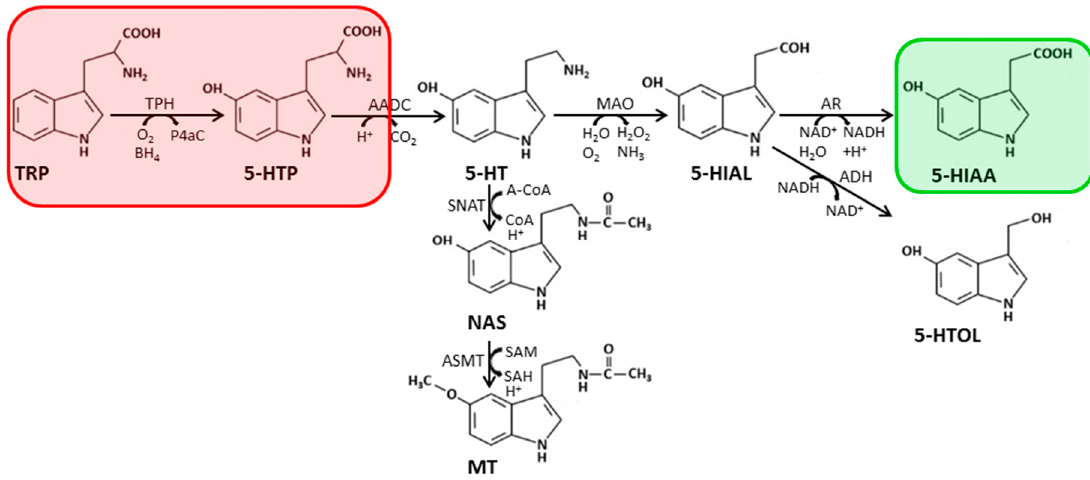
Figure 2. Biosynthesis and catabolism of tryptophan. A-CoA, acetyl coenzyme A; AADC, aromatic amino acid decarboxylase; ADH, alcohol dehydrogenase; AR, aldehyde reductase; ASMT, N -acetyl-serotonin- O -methyltransferase; CO 2 , carbon dioxide; CoA, coenzyme A; 5-HIAA, 5-hydroxyindolacetic acid; 5-HIAL, 5-hydroxyindolacetaldehyde; 5-HT, 5-hydroxytryptamine (serotonin); 5-HTOL, 5-hydroxytryptophol; 5-HTP, 5-hydroxytryptophan; H + , proton; H 2 O, water; H 2 O 2 , hydrogen peroxide; MAO, monoamine oxidase; MT, melatonin; NAD, nicotinamide dinucleotide; NAS, N -acetyl-serotonin; NH 3 , ammonia; O 2 , oxygen; P4aC, pterin-4-carbinolamine; SAM, S -adenosyl-methionine; SAH, S -adenosyl homocysteine; SNAT, serotonin- N -acetyltransferase; TRP, tryptophan. Marked in red is the BH 4 consuming reaction forming 5-HTP. Boxed in green is 5-HIAA, the most important analyte used for diagnosis in CSF.